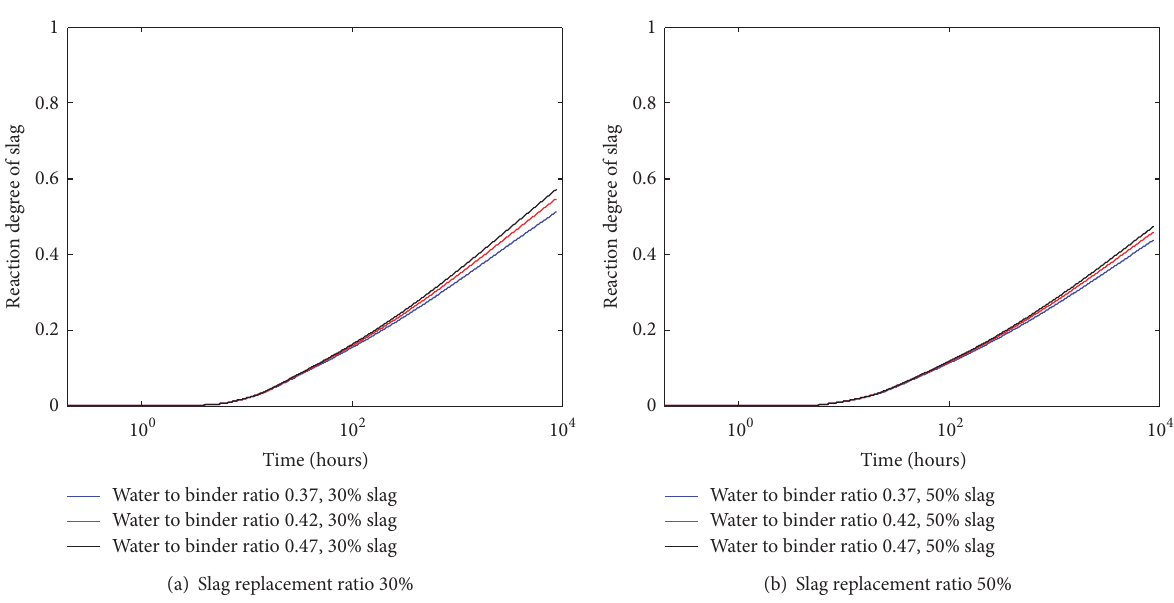
Figure 2: Reaction degree of